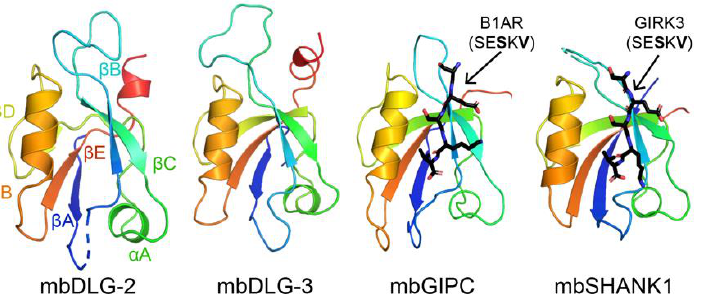
Figure 1. Structures of PDZ domains from Monosiga brevicollis are shown in cartoon representation, with the conserved secondary structure elements labeled in the mbDLG-2 figure. Bound peptides are in black sticks and colored by heteroatom (N = blue, O = red) and labeled. PDB ID codes for choanoflagellate PDZ domains from this work include: 6X1X, 6X20, 6X22, 6X23, 6X1P, 6X1N, and 6X1R [48].